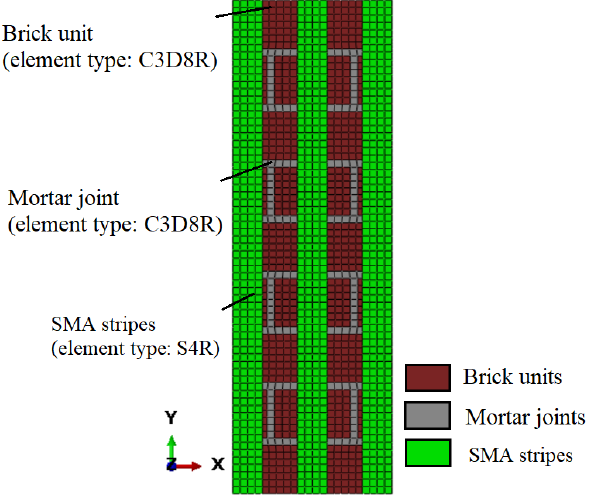
Figure 12. Schematic representation of retrofitted masonry prism with different types of FEs and materials.